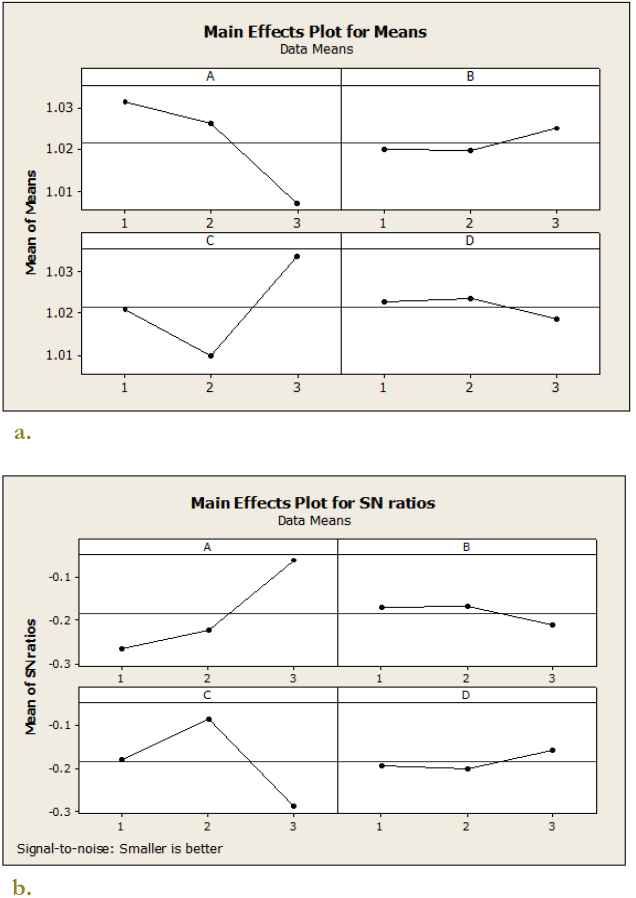
Fig. 2. Mean values and mean S/N ratio